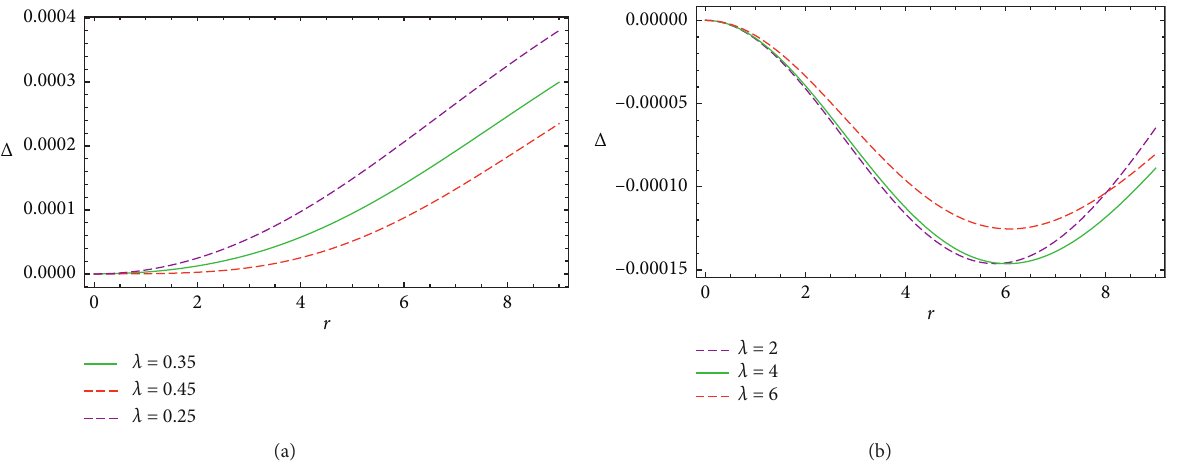
p r for small and large values of λ and for values of Vela X-1 defined in Table 1. r and t against